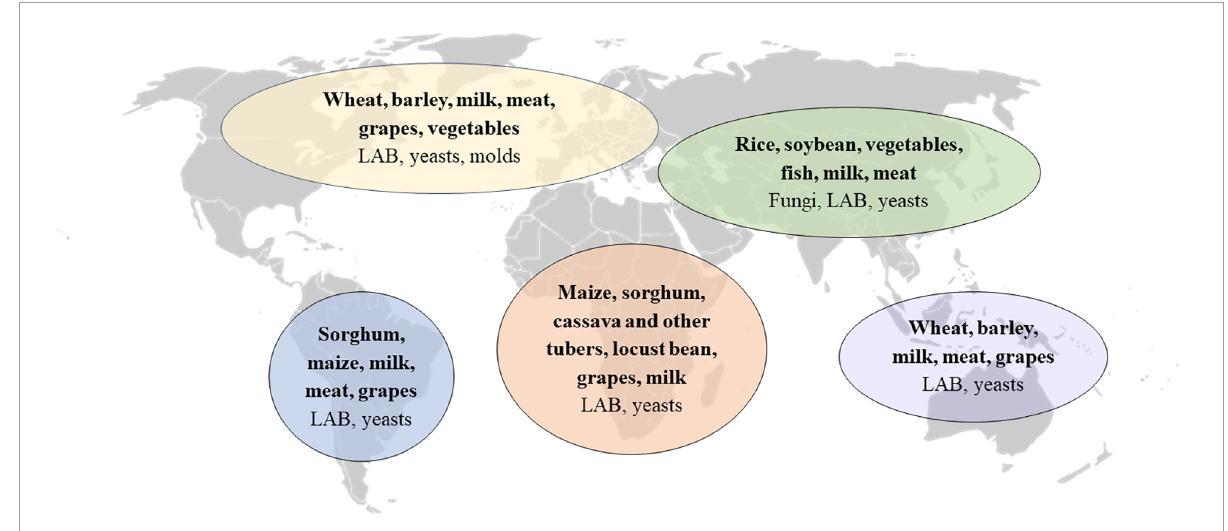
FIGURE1 Predominant fermented food substrates and microorganisms in regions around the world. Adapted from Tamang et al. (40). LAB, lactic acid